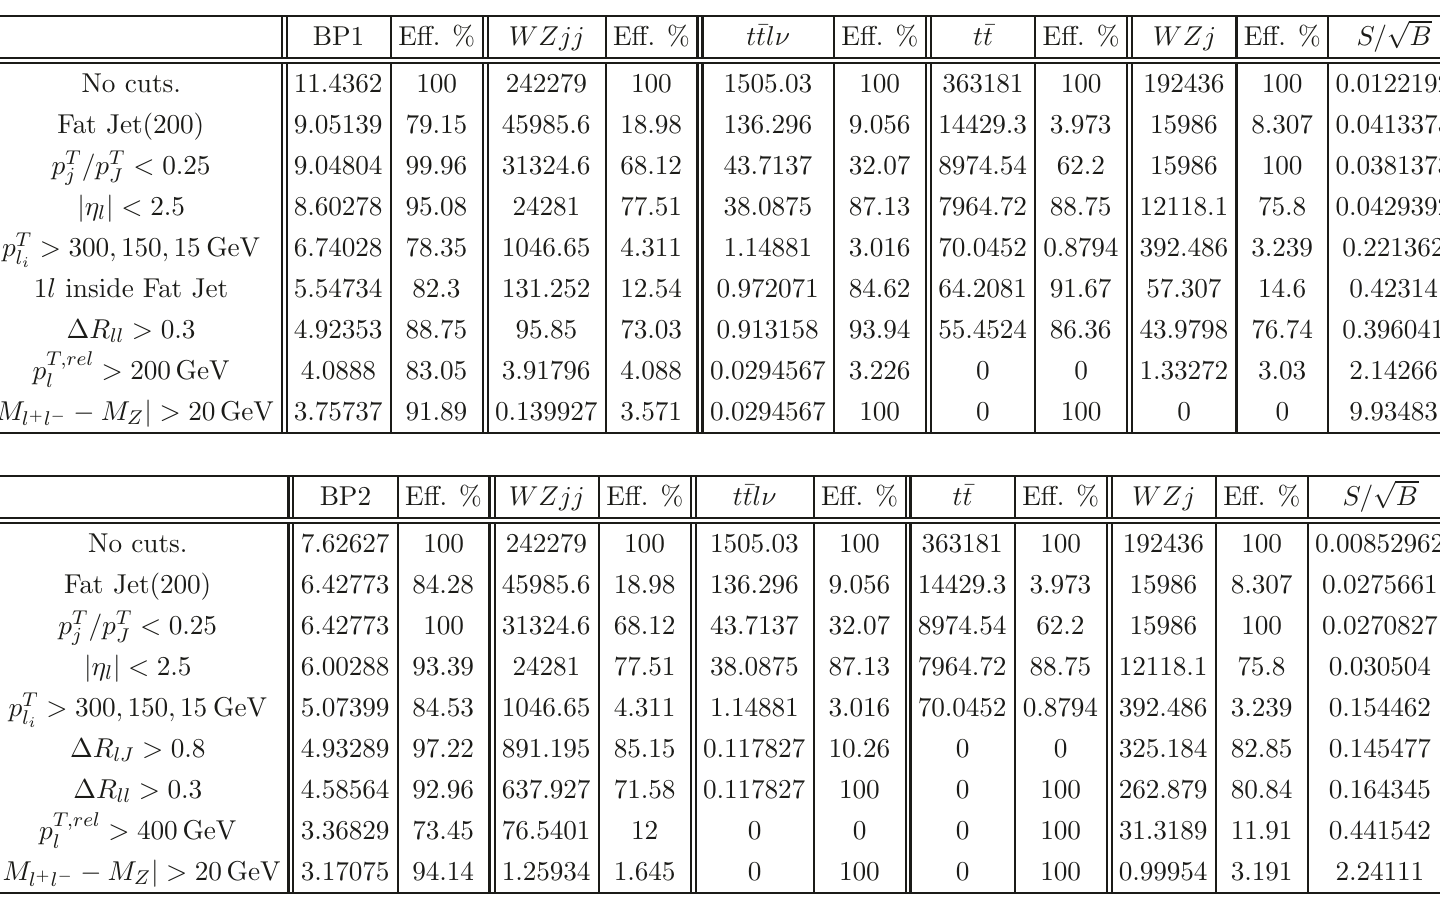
= 300 fb − 1 . Cut flow and efficiencies for signal and SM L